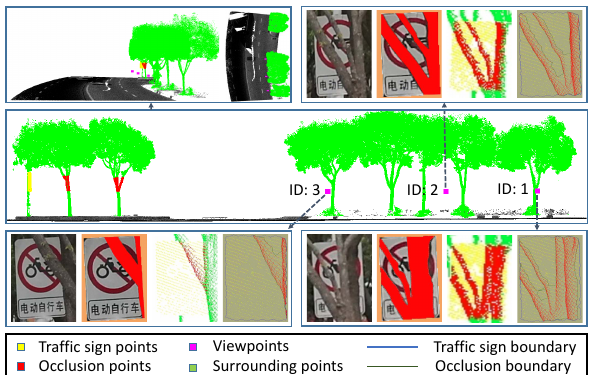
Figure 2. The example of evaluating the occlusion ratio accuracy in a real